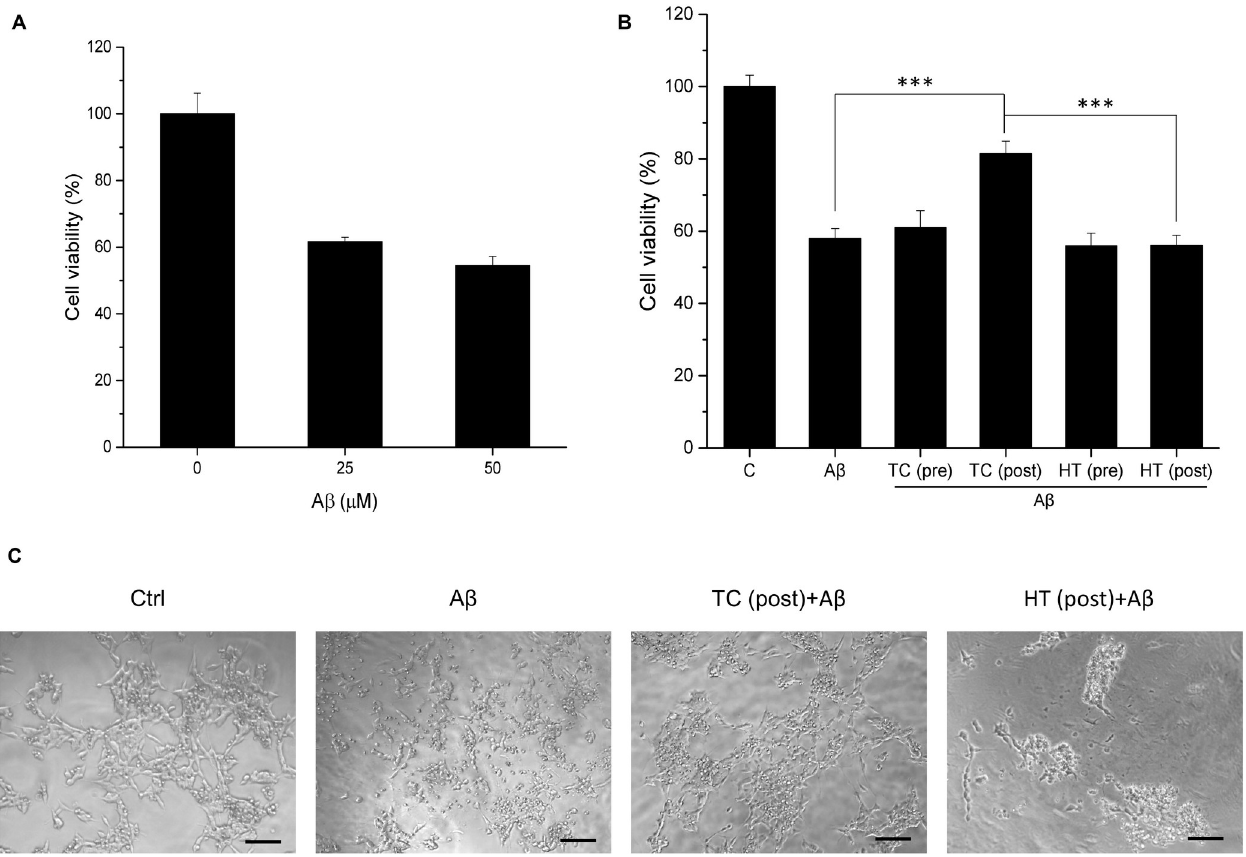
Fig 3. Effect of TC-HT on A β -induced cytotoxicity in SH-SY5Y cells. (A) The cell viability of SH-SY5Y cells treated with 25 or 50 μ M A β for 4 days. (B) The TC or HT pretreatment and post-treatment at 42.5˚C temperature setting were applied to the cells before or after 50 μ M A β administration, and the cell viability was measured by MTT assay 4 days after treatment. The TC or HT treatment was applied 4 h before the A β administration for the pretreatment group and 1 h after A β administration for the post-treatment group. (C) Representative light microscopy images of SH-SY5Y cells after treatment. The integrity of the cells was destructed by A β , and the TC post-treatment caused the protective effect and retained the cell morphology. Scale bar = 100 μ m. Data represent the mean ± standard deviation (n = 3). ��� P < 0.001.